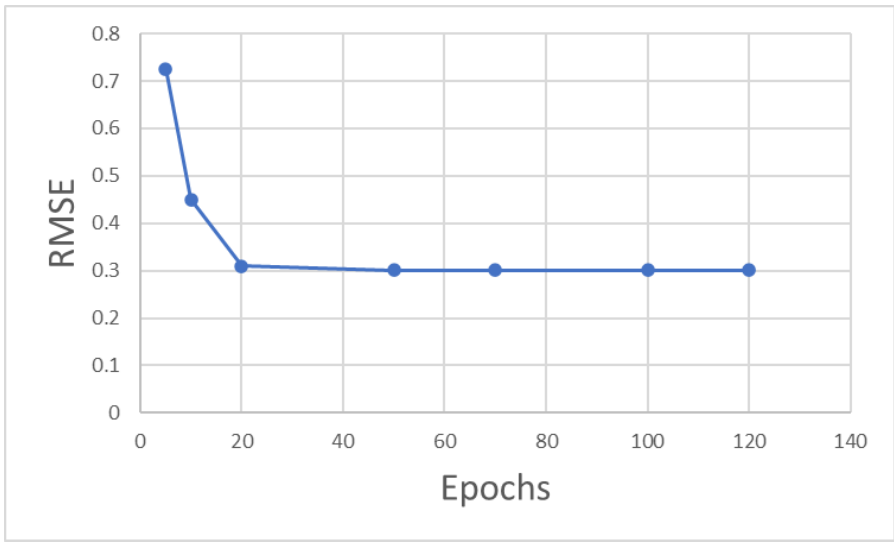
Figure 17. Effect of different epochs on model accuracy using frequency-domain data.